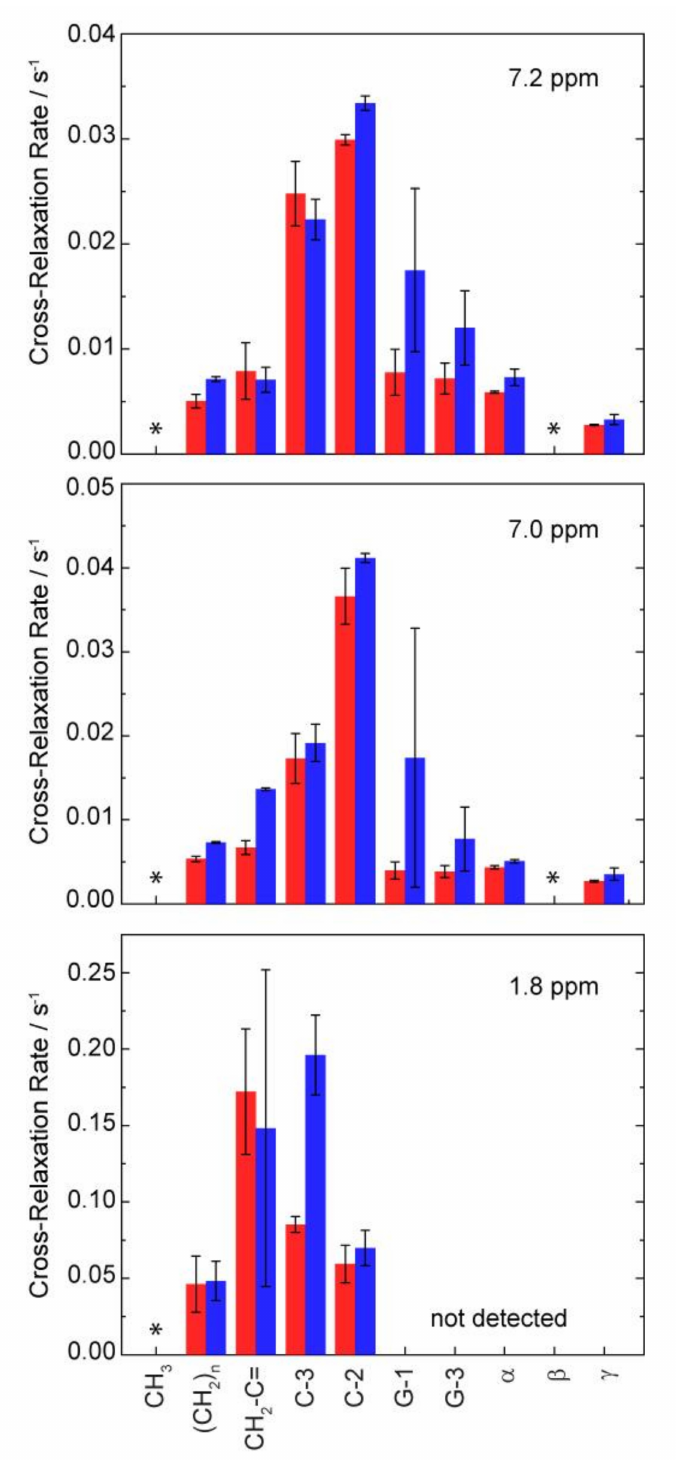
Figure 6. NOESY cross-relaxation rates between the three resolved signals of ibuprofen and the respective molecular segments of POPC along the membrane normal in POPC (red) and in POPC / cholesterol (80 / 20, mol / mol) (blue) membranes in the presence of 10 mol% ibuprofen. Cross-relaxation rates for the positions marked by * were not analyzed because of a significant signal overlap of ibuprofen and POPC signals. For the ibuprofen signal at 1.8 ppm, only cross peaks for the chain region of POPC were clearly